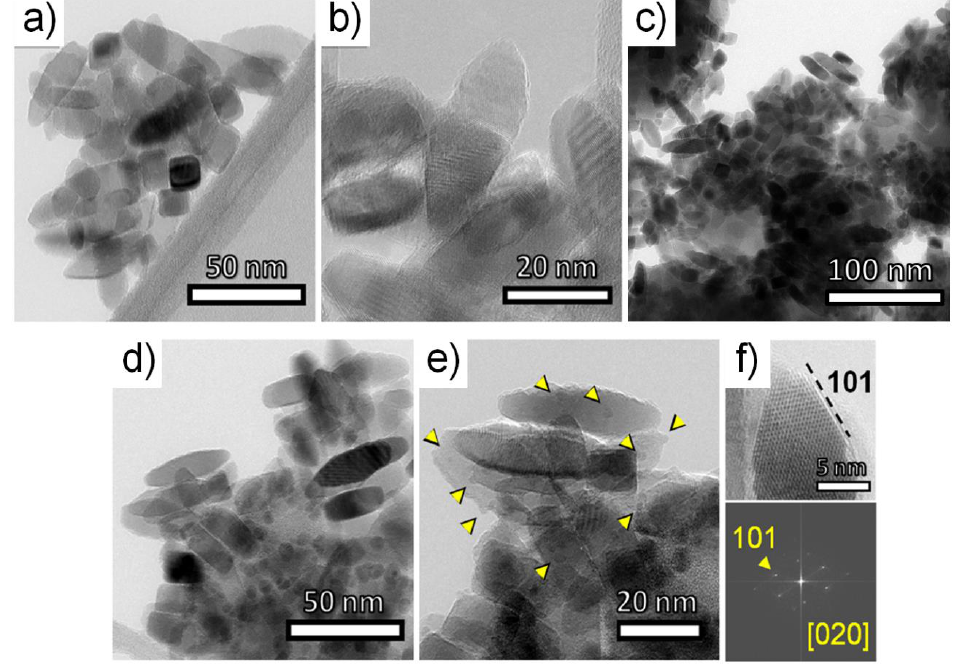
Figure 4. HRTEM images of ( a , b ) shape-controlled RE TiO 2 anatase NPs; ( c – f ) TiO 2 /HKUST-1 hybrid material. Yellow arrows in ( e ) highlight the close interaction between the two materials. Below the image ( f ) corresponding to Fast Fourier Transformation (FFT) of RE TiO 2 .